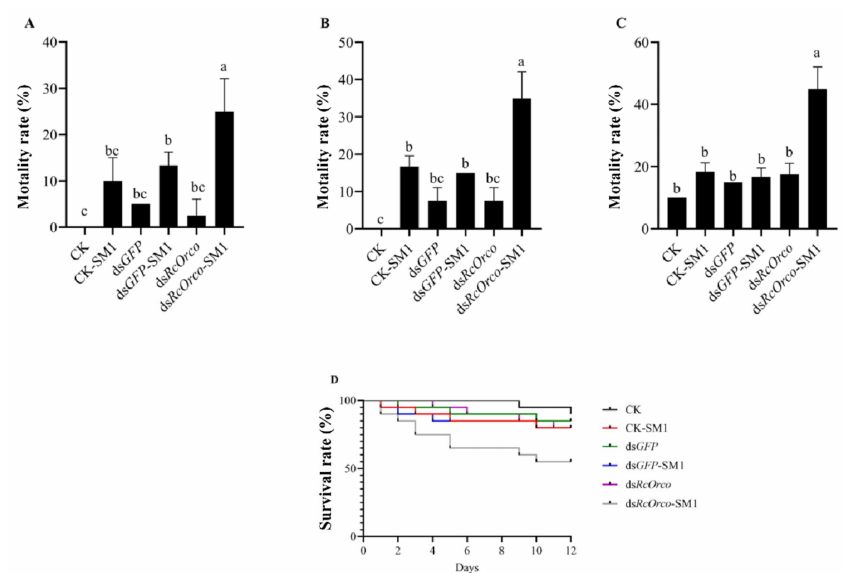
Figure 5. Bioassay of dsRcOrco combined with SM1 in R. chinensis ( A ) Mortality rate of each treatment group at 4 d. ( B ) Mortality rate of each treatment group at 8 d. ( C ) Mortality rate of each treatment group at 12 d. ( D ) Survival rate of each treatment group. The letters above the columns indicate different expressive differences.